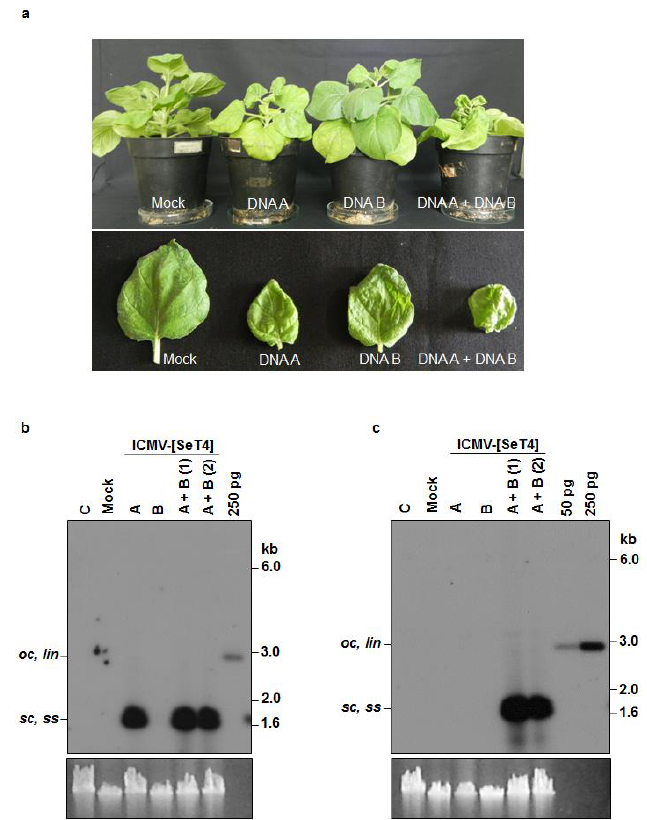
Figure 4. Infectivity analysis of ICMV-[SeT4] in N. benthamiana plants. ( a ) Symptoms displayed by N. benthamiana plants agroinoculated with the partial dimers of ICMV-[SeT4]. Bottom half shows individual leaves of the tested plants. ( b ) Southern blot analysis using ICMV-[SeT4] DNA A (ΔCR) labeled with [α- 32 P]dCTP as the probe. The plasmid pBS-ICMV-Tv-A digested with PstI (250 pg) was used as the positive control. ( c ) Southern blot analysis using [α- 32 P]dCTP-labeled ICMV-[SeT4] DNA B (ΔCR) as the probe. The plasmid pBS-ICMV-Tv-B digested with BamHI (50 pg and 250 pg) was used as the positive control. ( b , c ) DNA (1 µ g) from uninfected plant (C), plant mock infected with the A. tumefaciens strain Ach5 (Mock), plant agroinoculated with the partial dimers of DNA A alone (A), DNA B alone (B) and two plants independently co-agroinoculated with the partial dimers of DNA A + DNA B (A + B) were loaded in the respective lanes. Positions of different forms of viral DNA, single stranded ( ss ), super-coiled ( sc ), open circular ( oc ) and linear ( lin ), are marked. Ethidium bromide stained high molecular weight plant DNA is shown as loading control at the